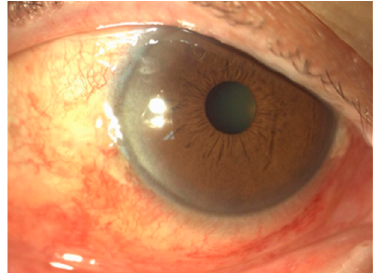
Figure 3. Mild conjunctival hyperemia 24 h postoperative.